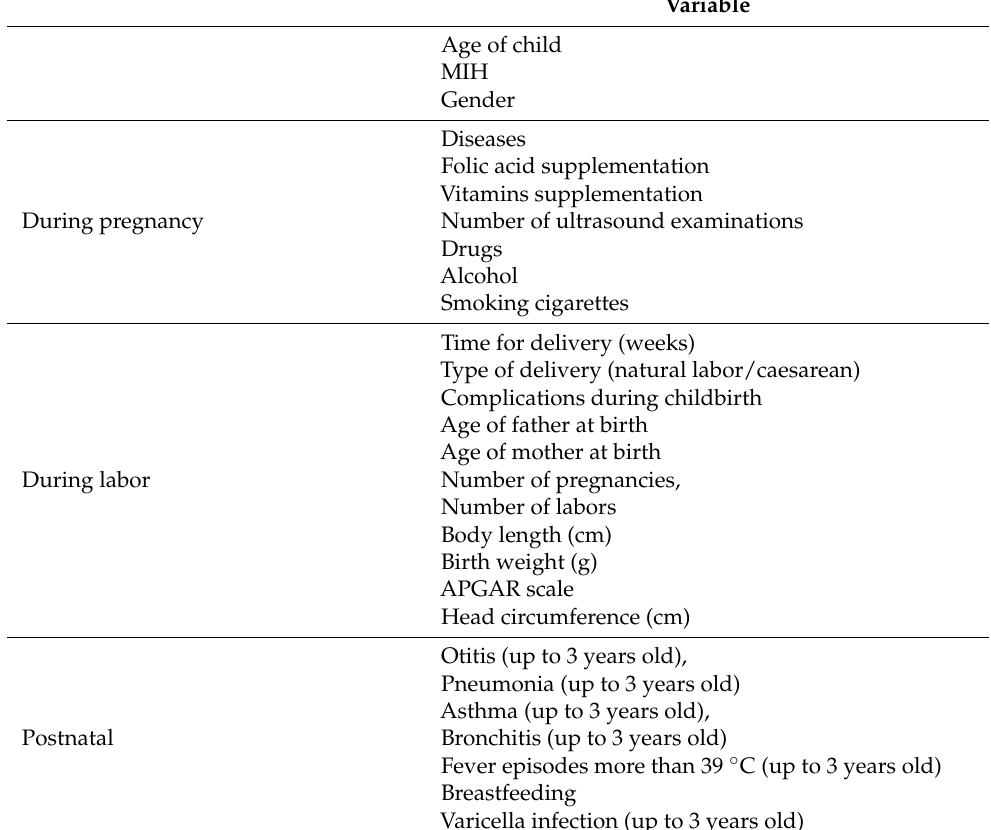
Table 2. Potential etiological factors for MIH development evaluated in the questionnaire.